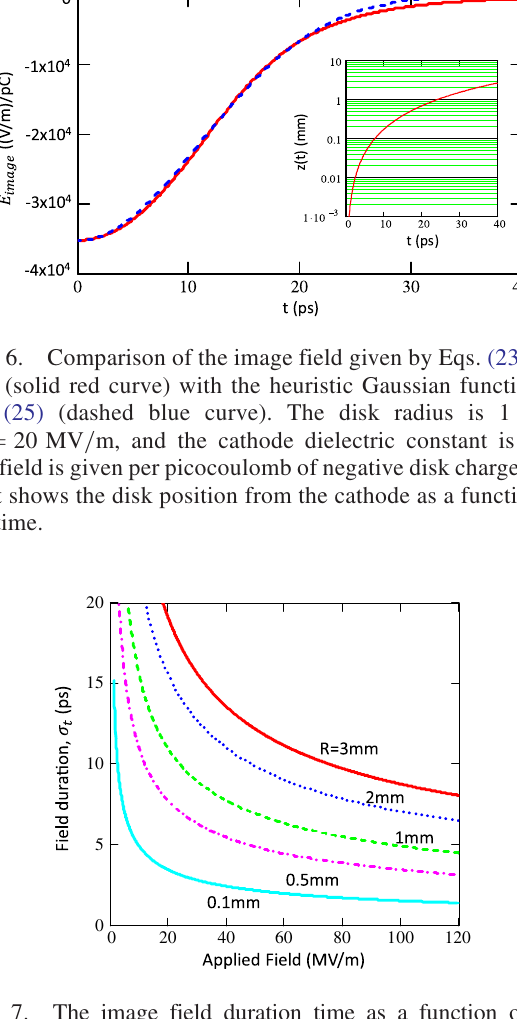
FIG. 7. The image field duration time as a function of the applied field for various disk